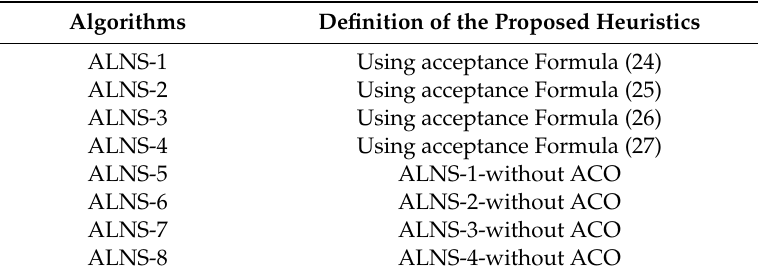
Table 8. Definition of the proposed heuristics.